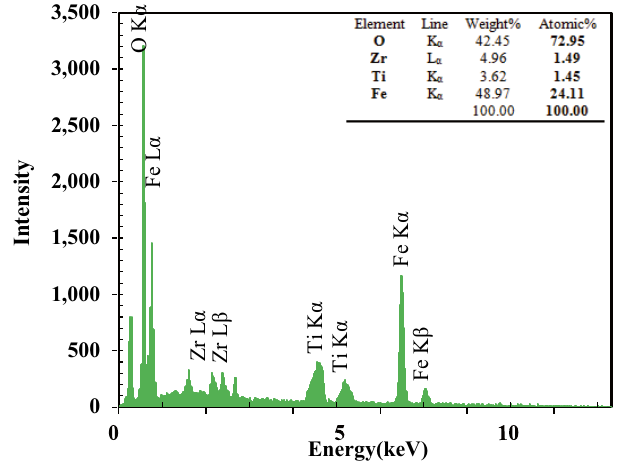
Figure 2. EDX spectrum. (Insert: Element analysis of synthesized